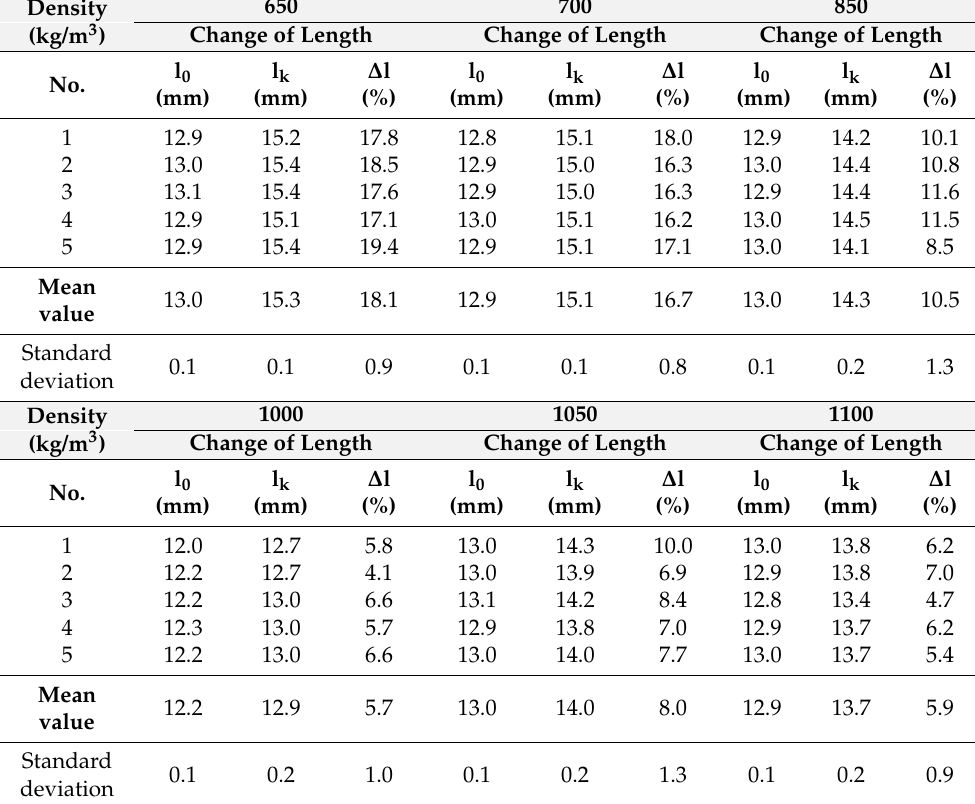
Table 5. Dimension changes of elastomeric materials after immersion in oil IRM